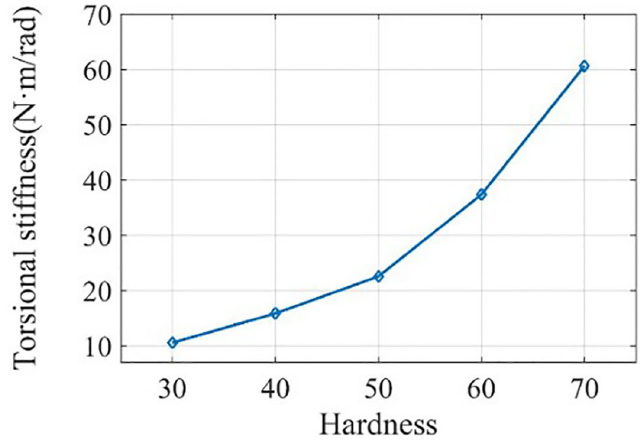
Fig 11. Torsional stiffness corresponding to different rubber ring properties.